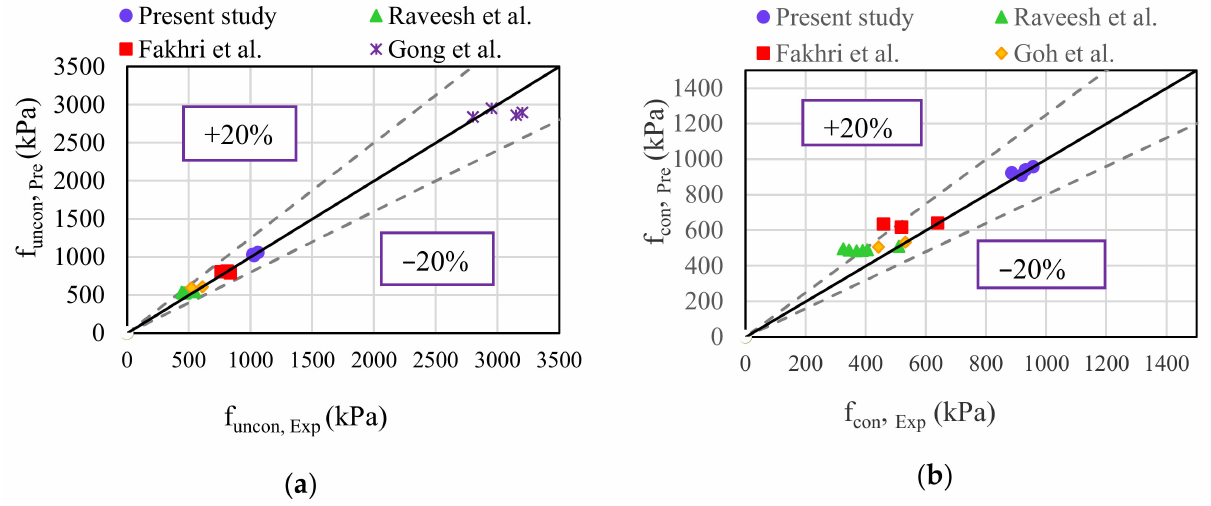
Figure 8. Comparison of the tensile strength results between the proposed model and the laboratory results of other researchers: ( a ) conditioned samples; ( b ) unconditioned